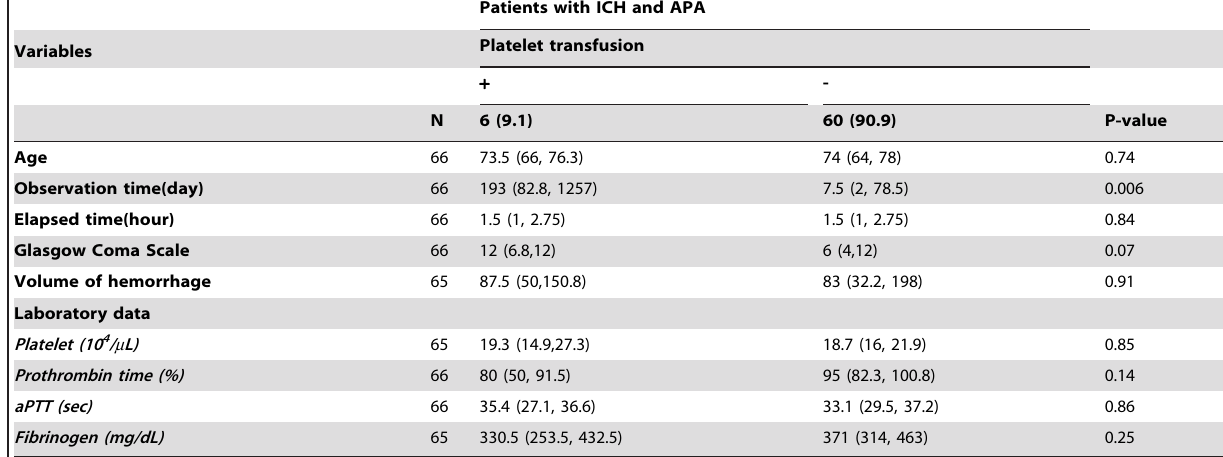
Table 5. Patient